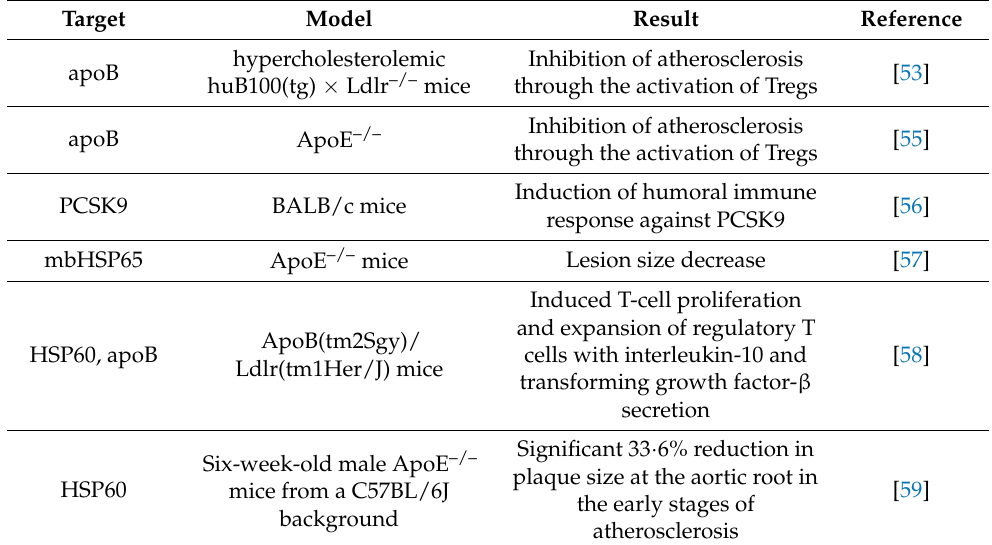
Table 1. Summary of experimental studies targeting various